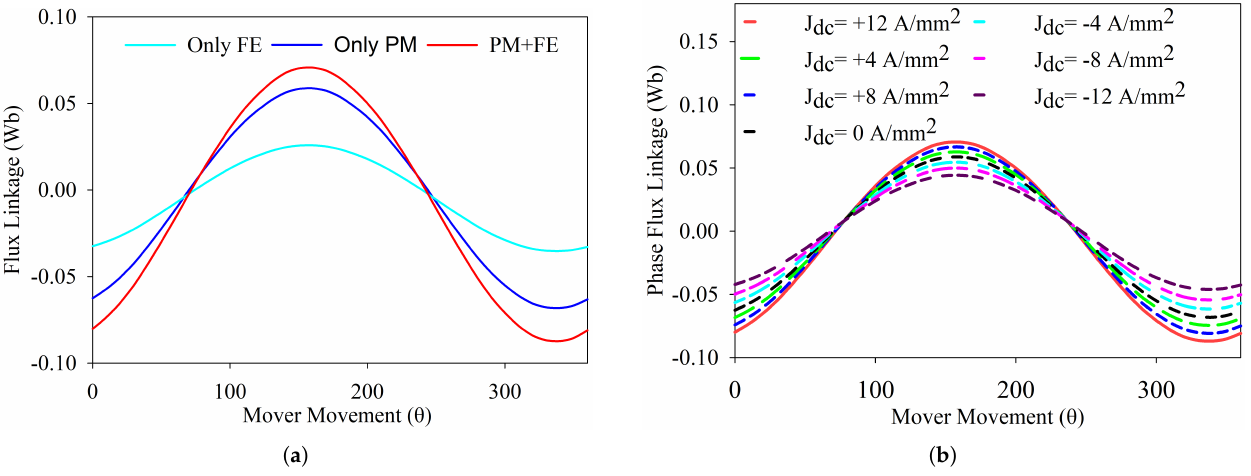
Figure 14. ( a ) Influence of FE on flux linkage ( b ) Flux regulation capability of the proposed single-sided VFPMLM with field current